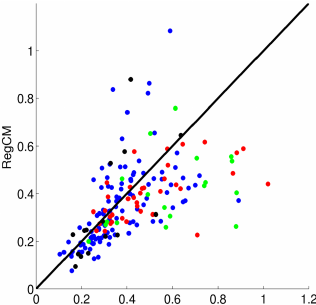
Figure 8. Simulated monthly AODs vs AERONET measured monthly AODs for the period of 2000–2009. Blue dots represent the solar Village Station (46.40 ◦ E, 24.90 ◦ N), red dot represent the Karachi station (67.03 ◦ E, 24.87 ◦ N), green dots represent Kuwait Airport station (47.98 ◦ E, 29.22 ◦ N) and black dots the Meizera sta- tion (53.8 ◦ E, 23.15 ◦ N). The correlation coefficient between data and measurements is equal to 0.59 and the root mean square error is